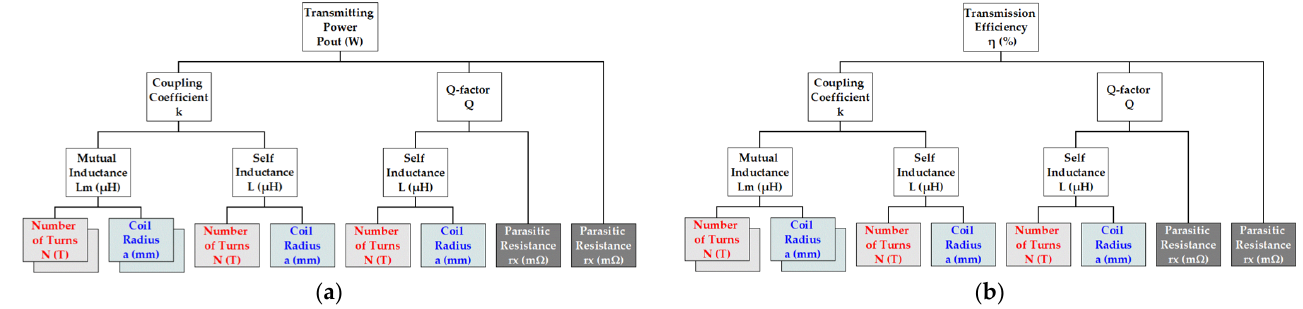
Figure 4. Separated diagrams of expressions for ( a ) transmitting power and ( b ) power transfer efficiency of the WPT system.